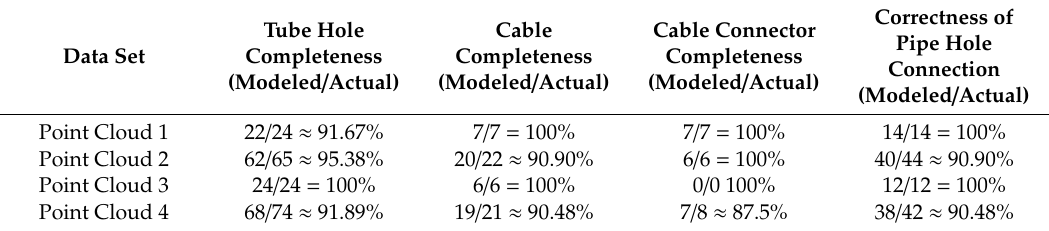
Figure 19. Internal cable model generation. ( a ) Point Cloud 1 internal models, ( b ) Point Cloud 2 internal models, ( c ) Point Cloud 3 internal models, and ( d ) Point Cloud 4 internal models. Table 4. The quantitative evaluation of internal model Completeness.